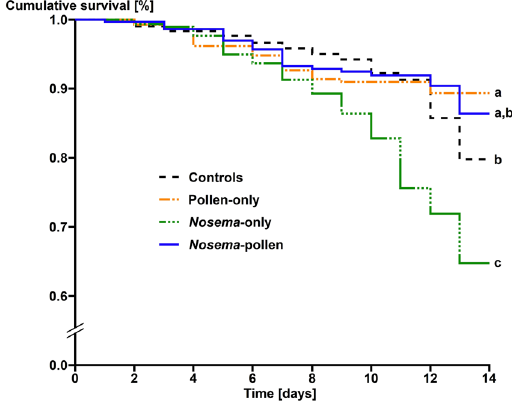
Figure 1. Cumulative survival of honey bee workers exposed to the different treatments over time. Workers contaminated with N. ceranae from the pollen-only treatment are not considered. Significant differences (Log- Rank test P < 0.05) among treatments are indicated by different letters (a, b,